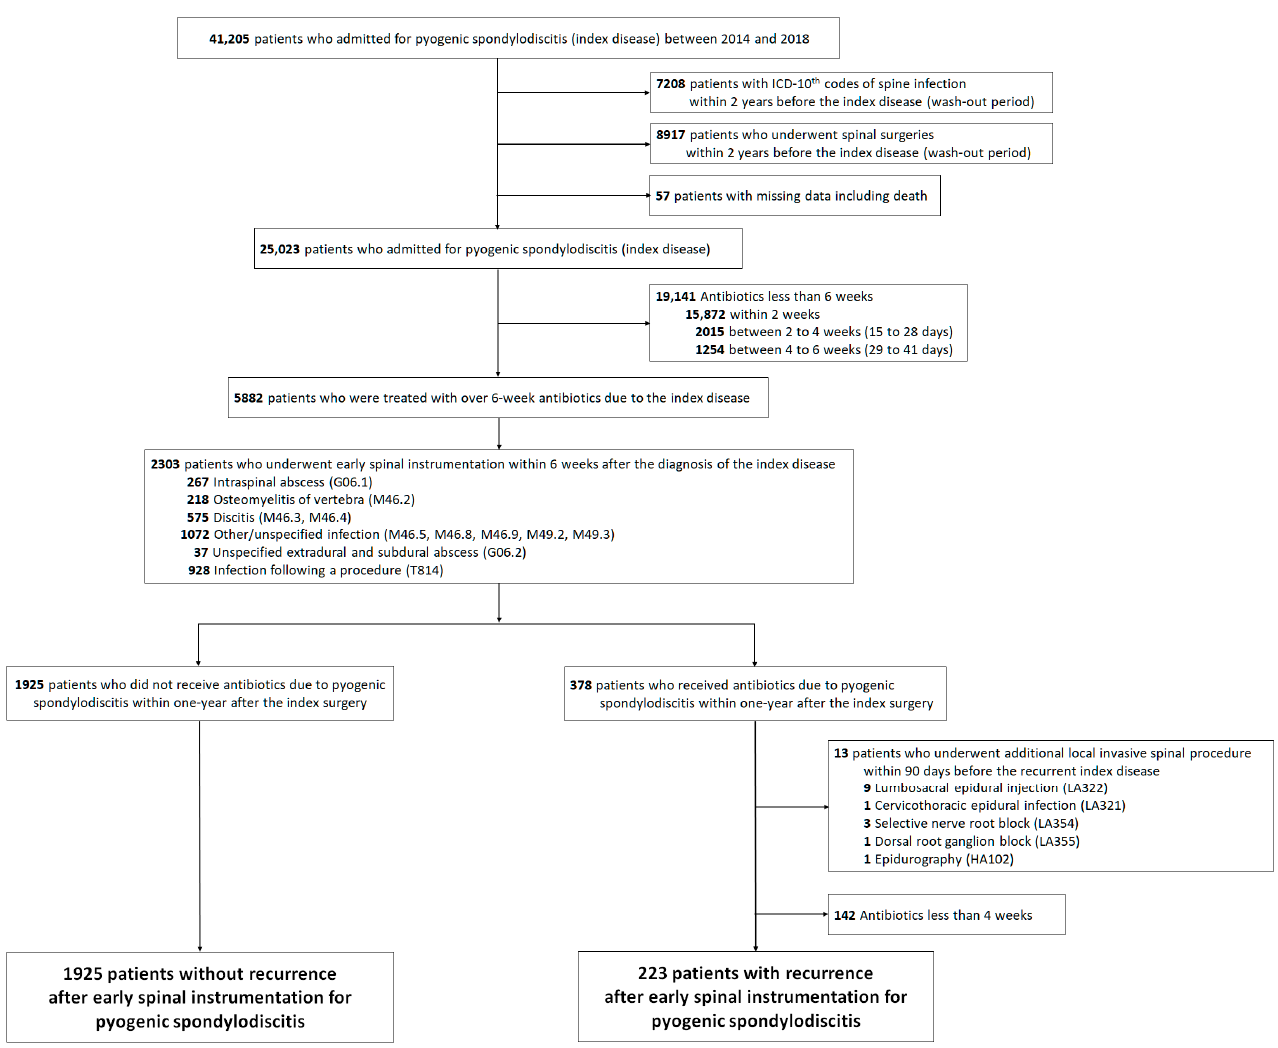
Figure 2. Selection of the study population. Table 1. Incidence of recurrence according to duration of therapeutic